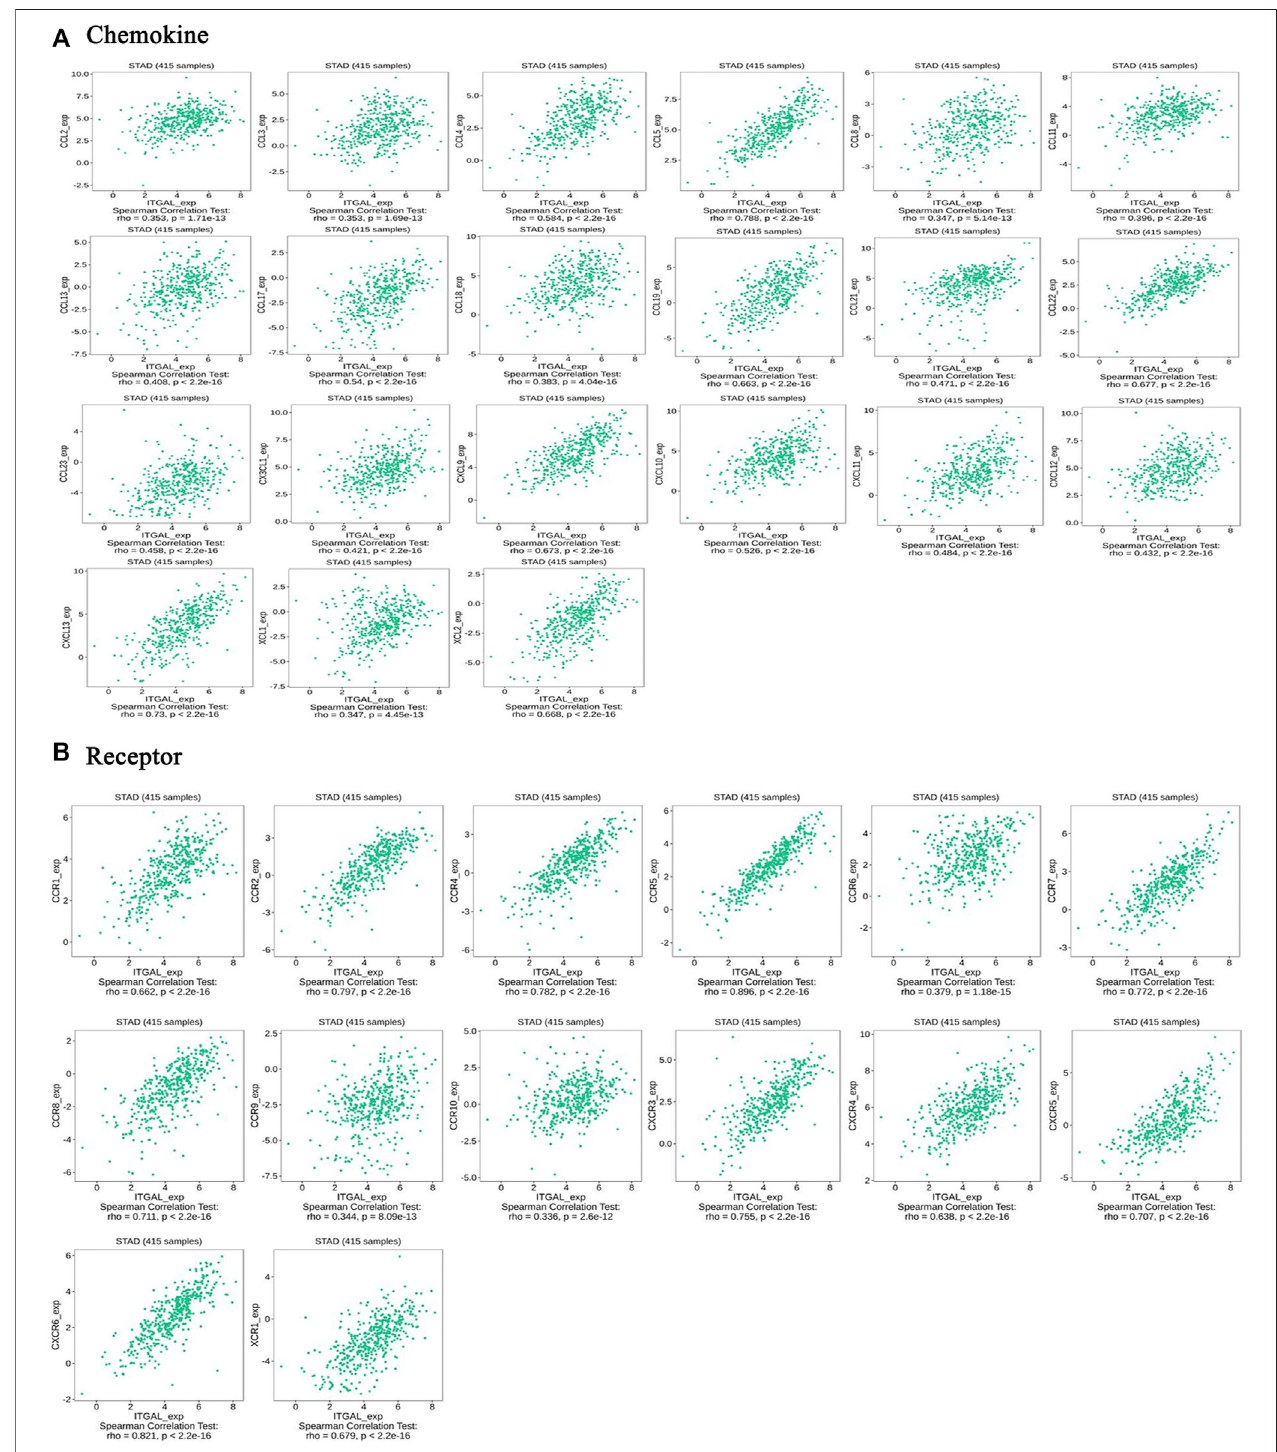
FIGURE7| Correlationbetween theexpression ofITGAL and chemokines ingastriccancer. (A) Correlation betweenITGAL expression and chemokinesingastric cancer available at TISIDB database. (B) Correlation between ITGAL expression and chemokine receptors in gastric cancer available at TISIDB database. Color images are available